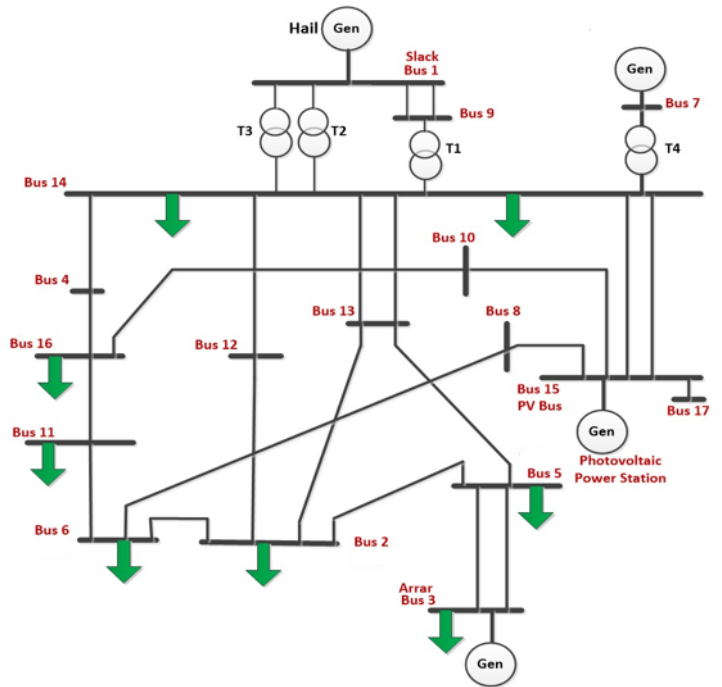
Figure 21. Single line diagram of the Aljouf transmission grid with SPVG connected.